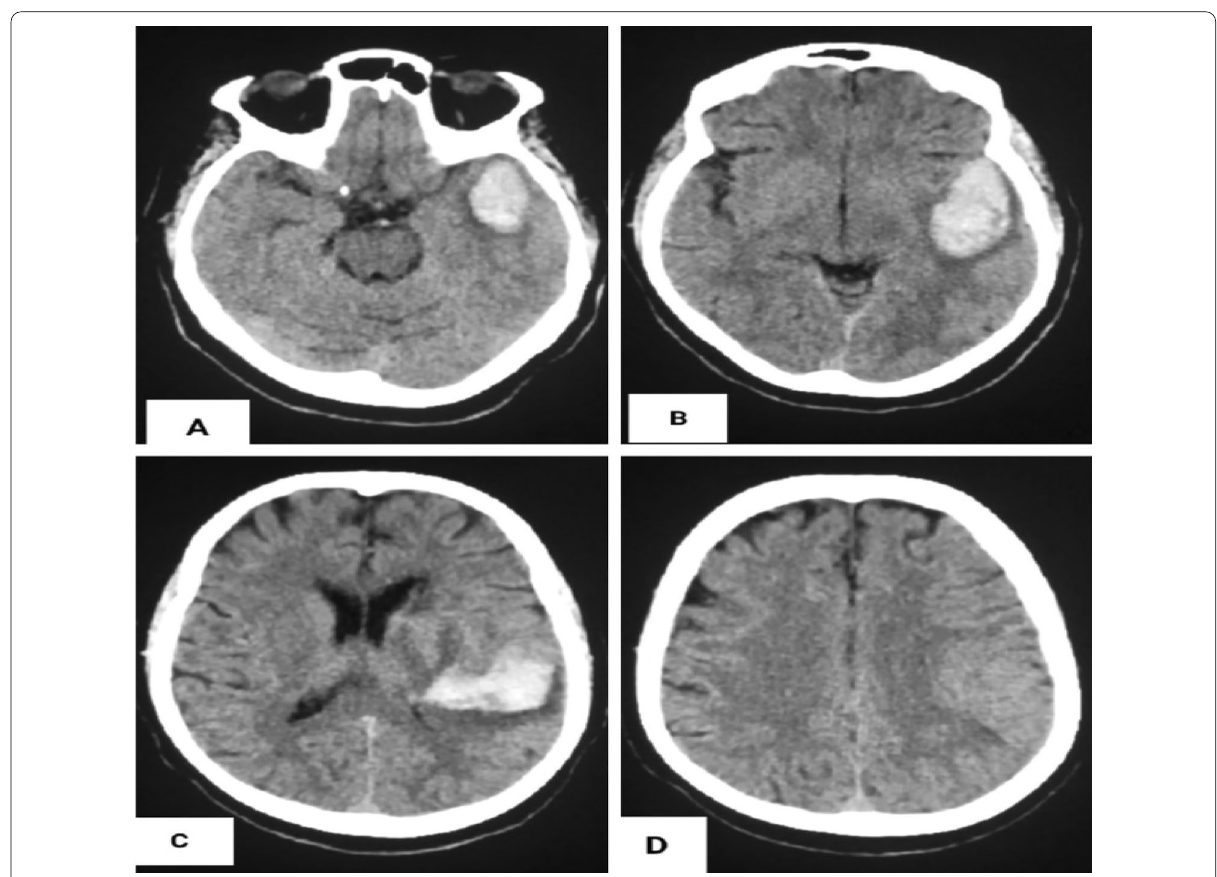
Fig. 1 A – D Computed tomography scan of the brain showing left temporoparietal